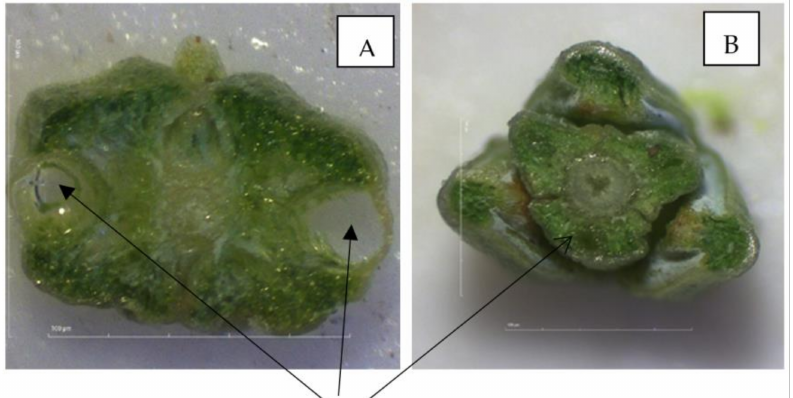
Figure 3. Images of the endogenic cavities of the leaves of J. sabina ( A ) and J. excelsa ( B ) taken using a Stereo Microscope DM-143-FBGG, Motic Images Plus